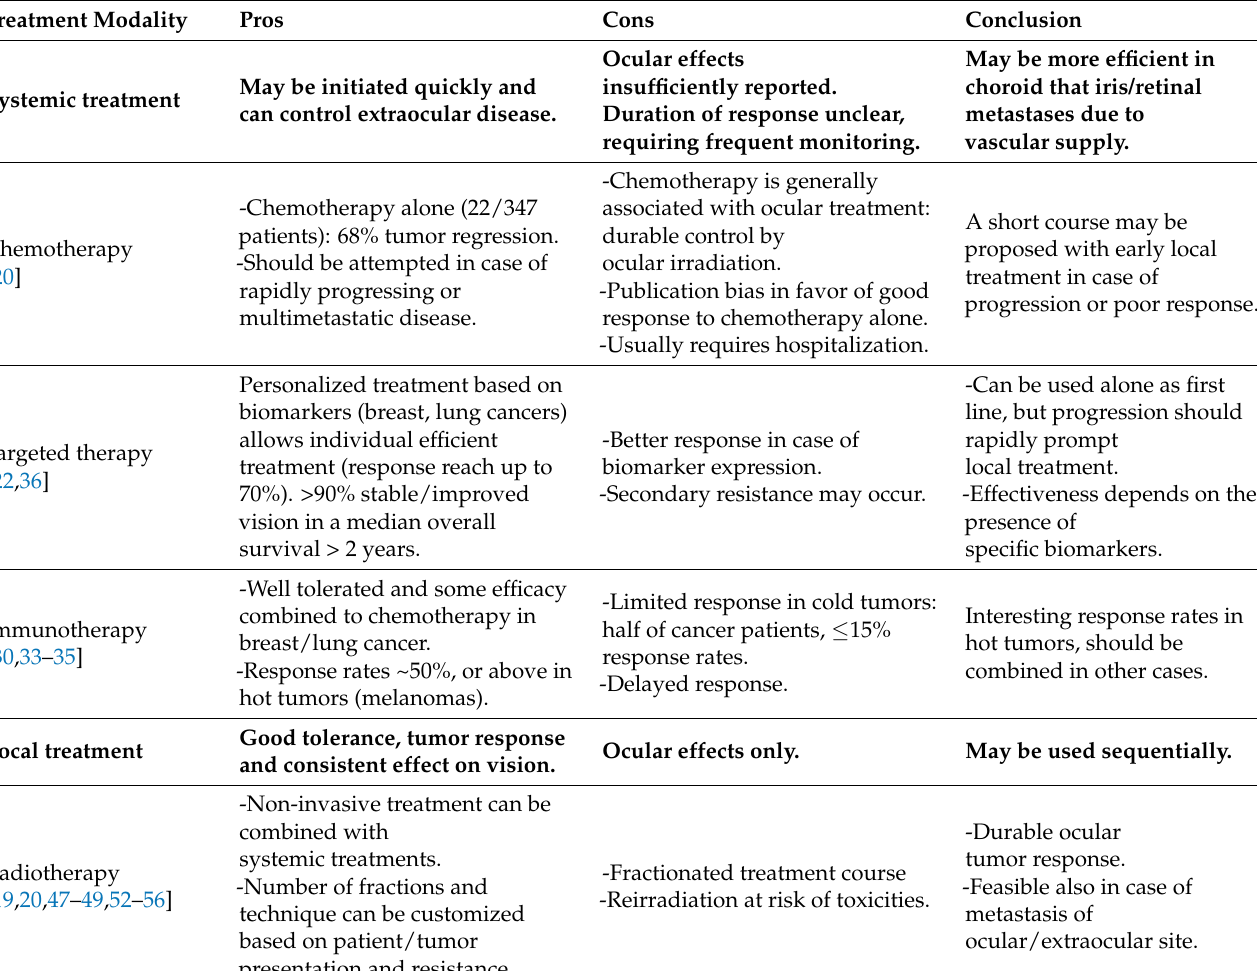
Table 1. Pros and Cons of each treatment